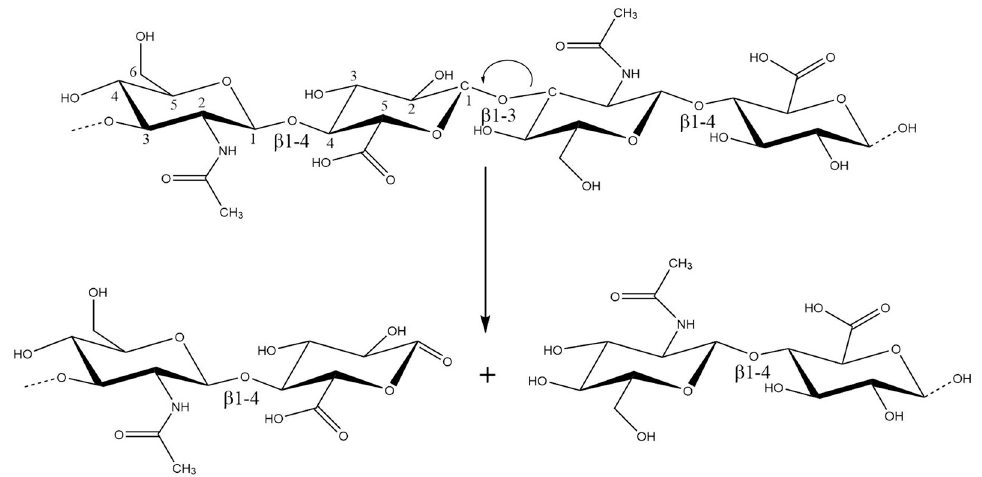
Figure 2. The radicals at carbons, which form glycosidic bonds, undergo a β -scission reaction resulting in the breakdown of the HA chains at C1 of the GlcA residue.